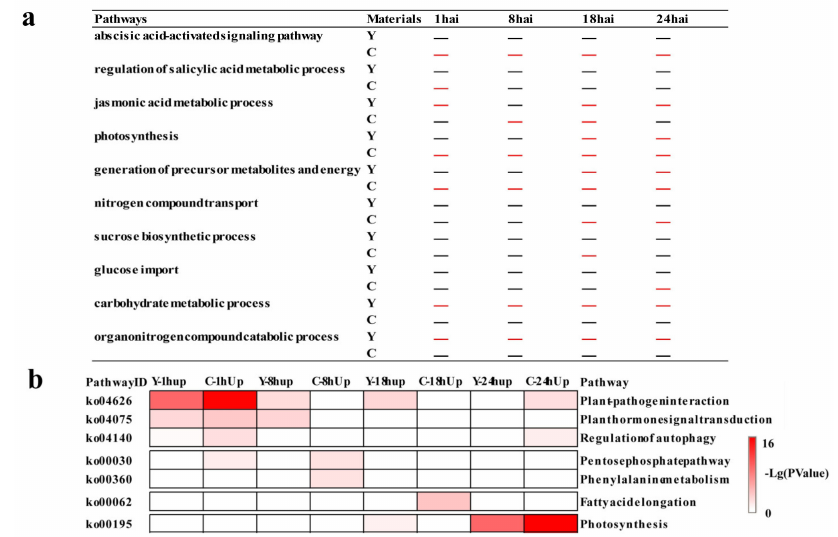
Figure 3. GO classification and KEGG pathways enrichment in CMPG1-V OE and susceptible receptor Yangmai 158 from 1 hai to 24 hai after Bgt infection. ( a ) GO analysis of special upregulated genes in Yangmai 158 and CMPG1-V OE from 1 hai to 24 hai. ( b ) Heat map showing the P -value significance of enriched KEGG pathways of upregulated DEGs in CMPG1-V OE and Yangmai 158 from 1 hai to 24 hai. Y represents Yangmai 158, C represents CMPG1-V OE . The colors white, pink, and red represent low, medium, and high expression levels, respectively. Upregulated pathways were selected as follows: P value < 0.05; genes with the regulation ratio log ≥ 2 or ≤− 2 were